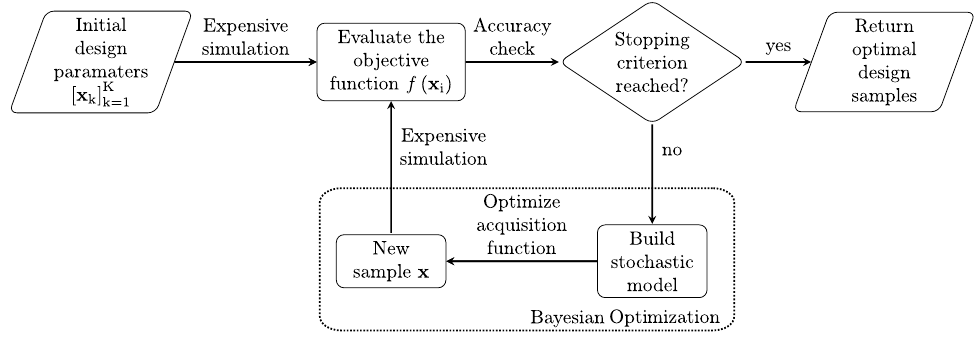
Figure 2. Flowchart of the BO